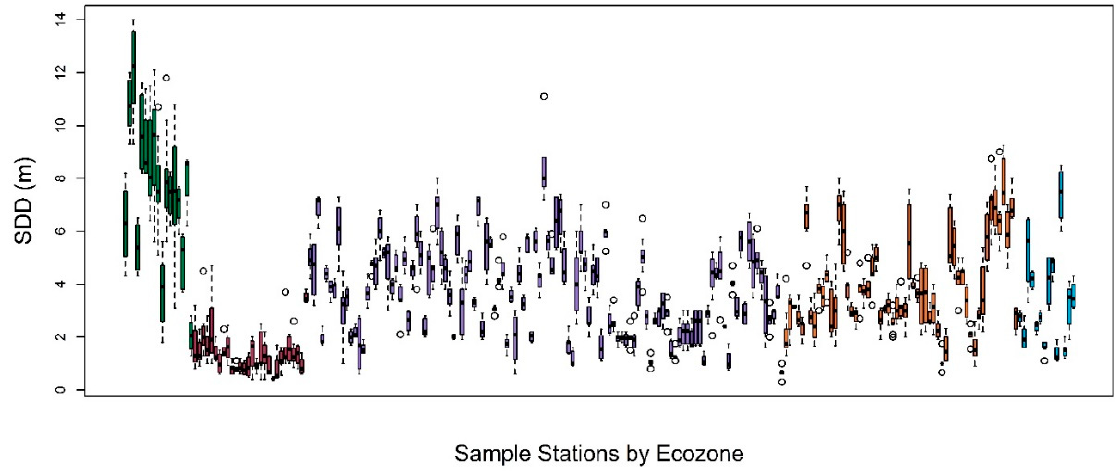
Figure 2. Boxplots showing distribution of SDD values for each sample station that had >4 repeat measurements (unique sampling points) over the study period (2013–2019). Boxes are color-coded by ecozone, consistent with previous plots. Green represents the Pacific Maritime and Montane Cordilleran, maroon represents the Boreal Plain and Prairies, purple represents the Boreal Shield, orange represents the Mixed Wood Plains, and blue represents the Atlantic Maritime.